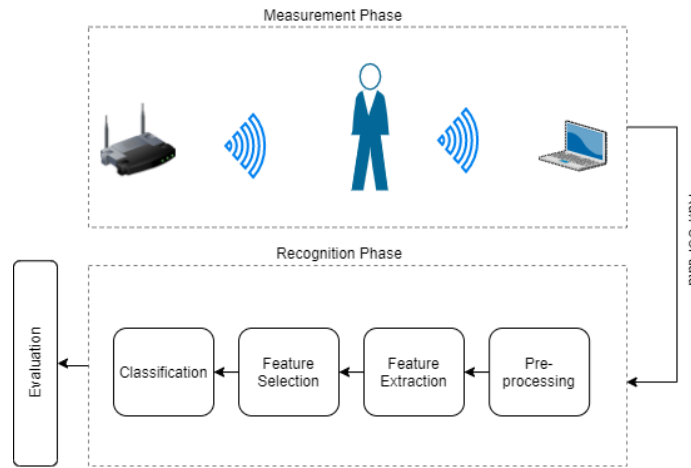
Figure 1. Standard pipeline of activity recognition using WiFi CSI data.